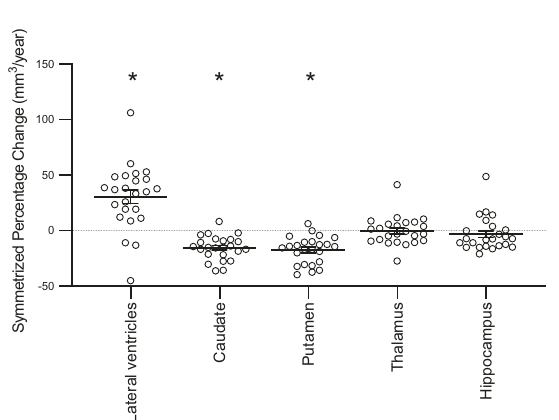
Fig. 1 Symmetrized percentage change (SPC) in subcortical volumes 12 weeks after switching to clozapine treatment. The graph presents the individual data points, together with the mean and standard error of the mean for each volume. Increases in lateral ventricle volume and decreases in caudate and putamen volume signi fi cantly differed from zero (* One sample T-test; P < 0.01). Please note SPC values are 4 – 5 fold greater than the percentage change (Table